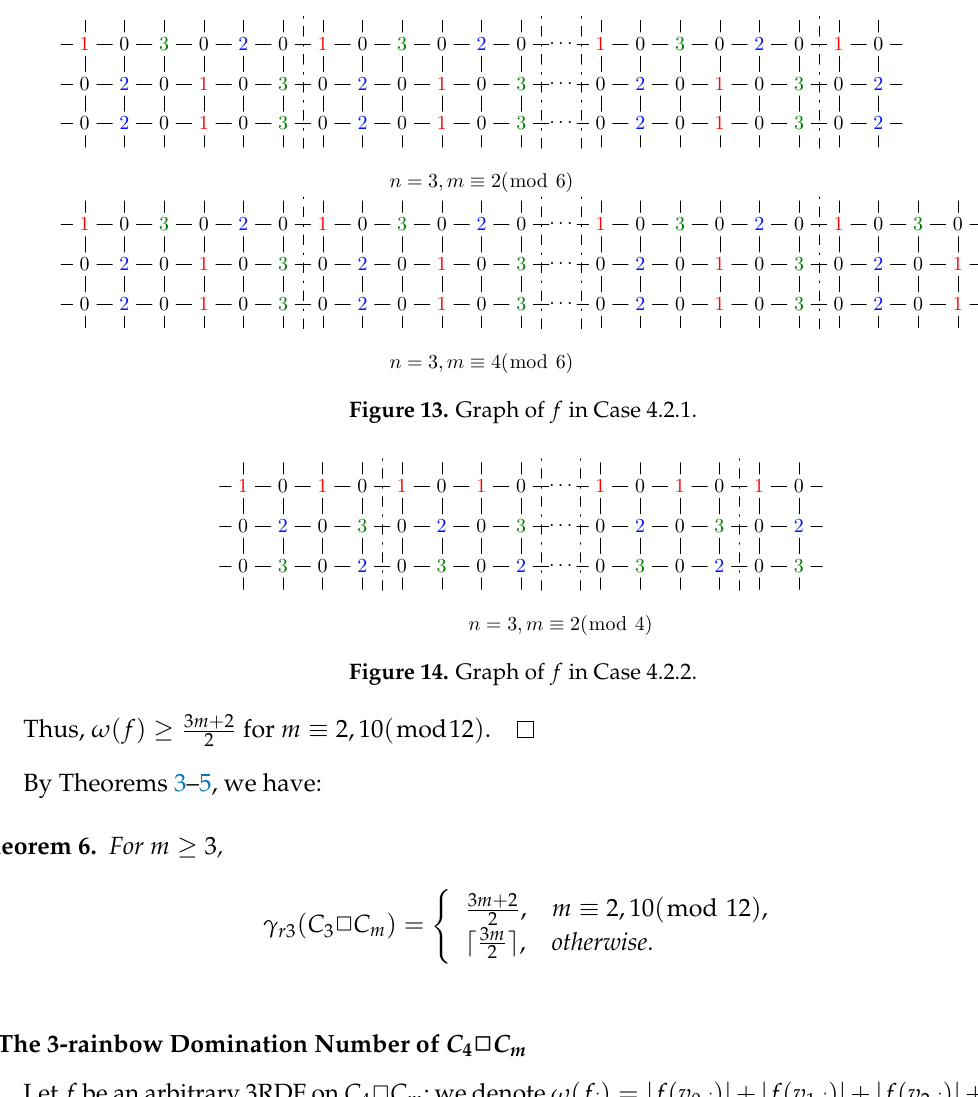
Figure 14. Graph of f in Case 4.2.2